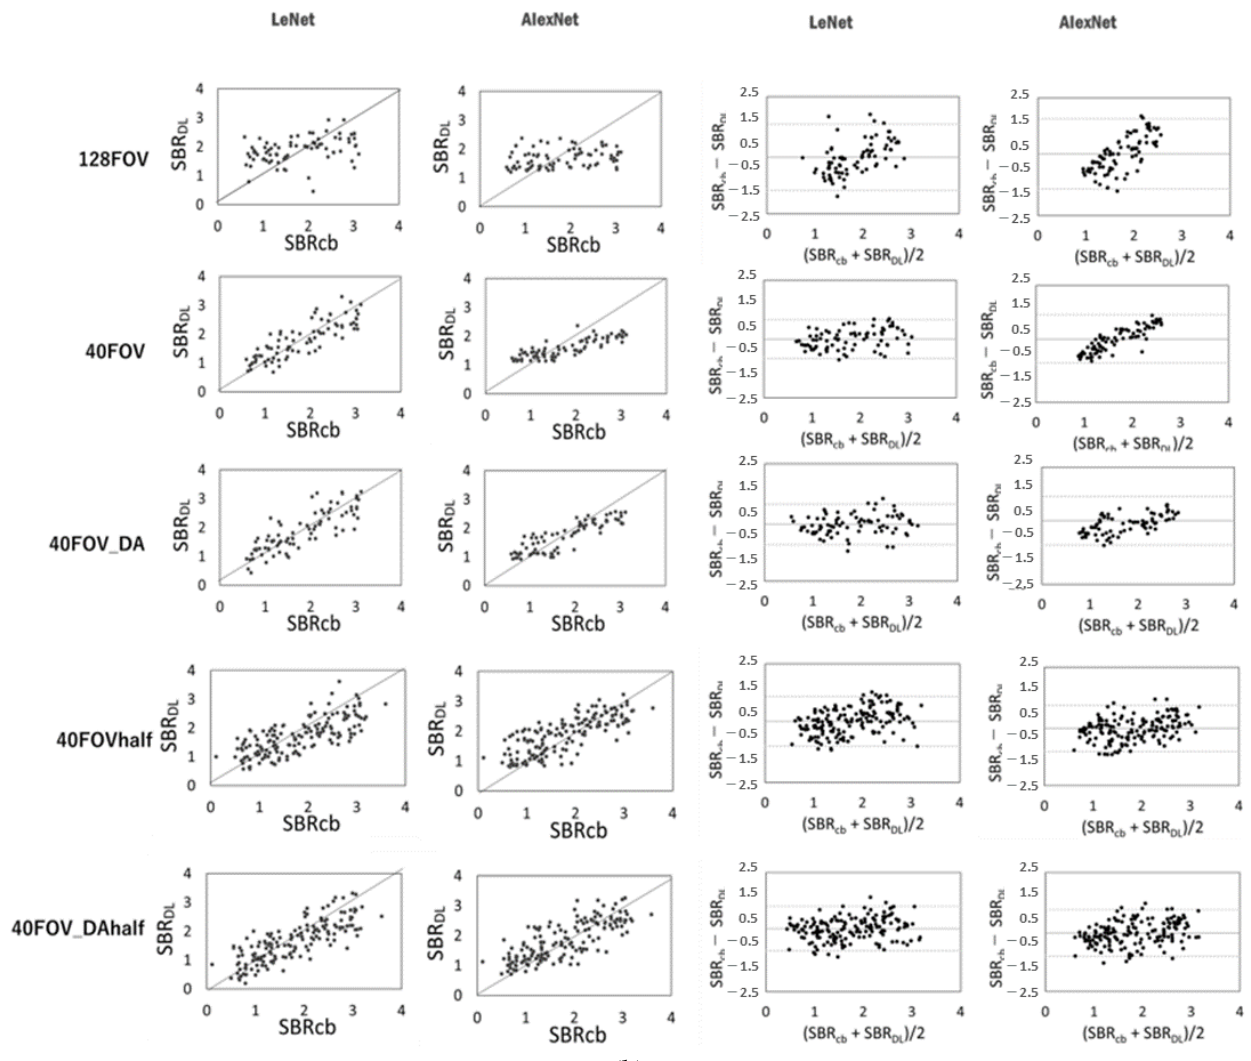
Figure 3. Scatter plots of conventional specific binding rate (SBR) (SBR BT or SBR cb ) and SBR (SBR DL ) for each dataset and network using the DaT view ( a , left half) and the count-based methods ( b , left half). The solid line is the line of identity. Right half shows the corresponding Bland–Altman plot for each SBR. Black lines represent the mean bias; the upper and lower dotted lines are 1.96 standard deviation. Figure 4 shows the original 0° projection image and the heat map image of Grad- CAM for 128FOV (Figure 4a, top) and 40FOV (Figure 4a, bottom). In the Grad-CAM of 128FOV, the many background dots indicate that the CNN focused on the background and the brain in many cases. The 40FOV of the same case at the bottom shows that the small FOV was centered on the striatum, and the CNN focused on the brain. Figure 4b includes [ 123 I]FP-CIT uptake in the parotid gland. In the Grad-CAM of the 128FOV (Figure 4b, top), the color dots in the parotid gland indicate that the CNN focused on the parotid gland in addition to the background. On the other hand, the image of the 40FOV (Figure 4b, bottom) was cropped around the striatum, and the parotid gland was out of the field of view, indicating that the CNN was not focused on parotid accumulation.